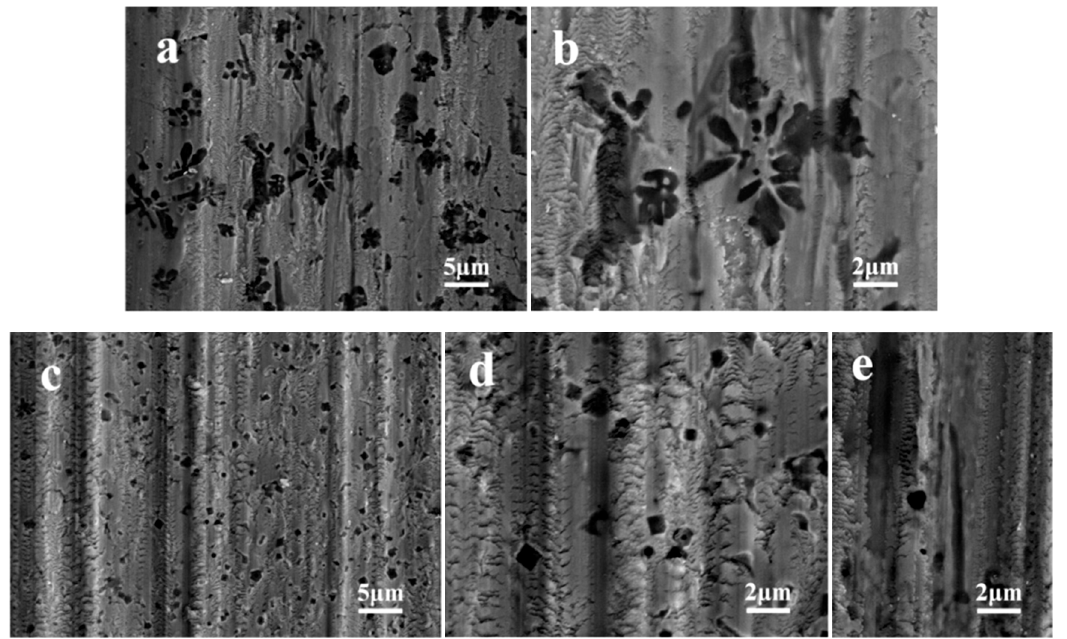
Figure 5. ( a ) The average microhardness on the upper surface and ( b ) the friction coefficients of the cladding layers.